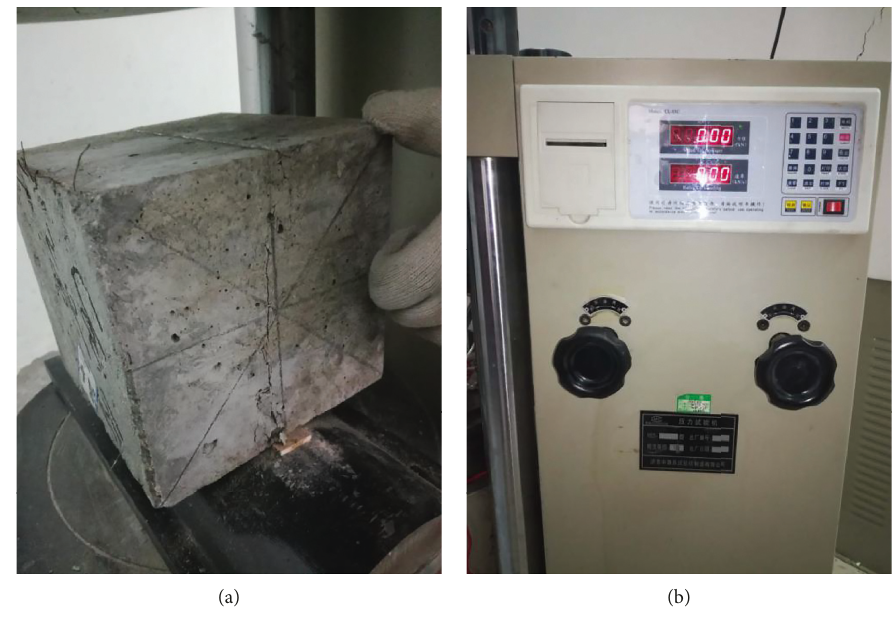
Figure 7: Cube splitting tensile strength testing